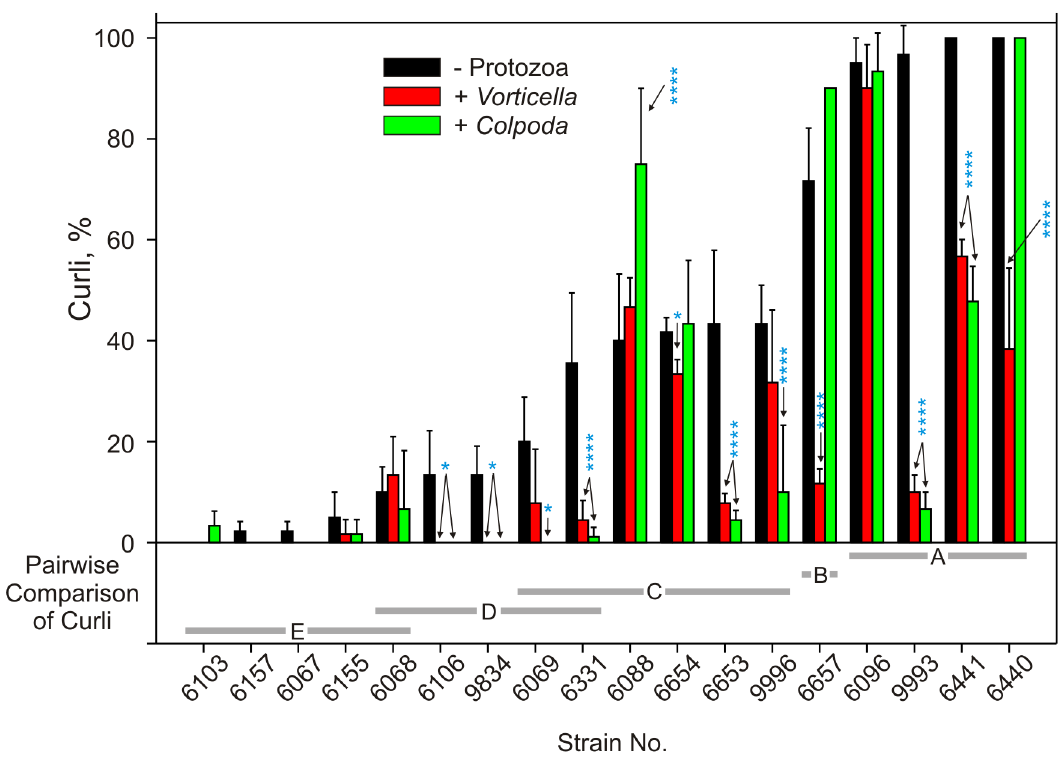
Figure 2. Effect of protozoan predation on curli-variant subpopulations of EcO157 strains. Proportion of C variants was monitored both in the presence or absence of protozoa. Values are averages of triplicates. Bonferroni post tests: * = P , 0.05; ** = P , 0.01; *** = P , 0.001; **** = P , 0.0001.